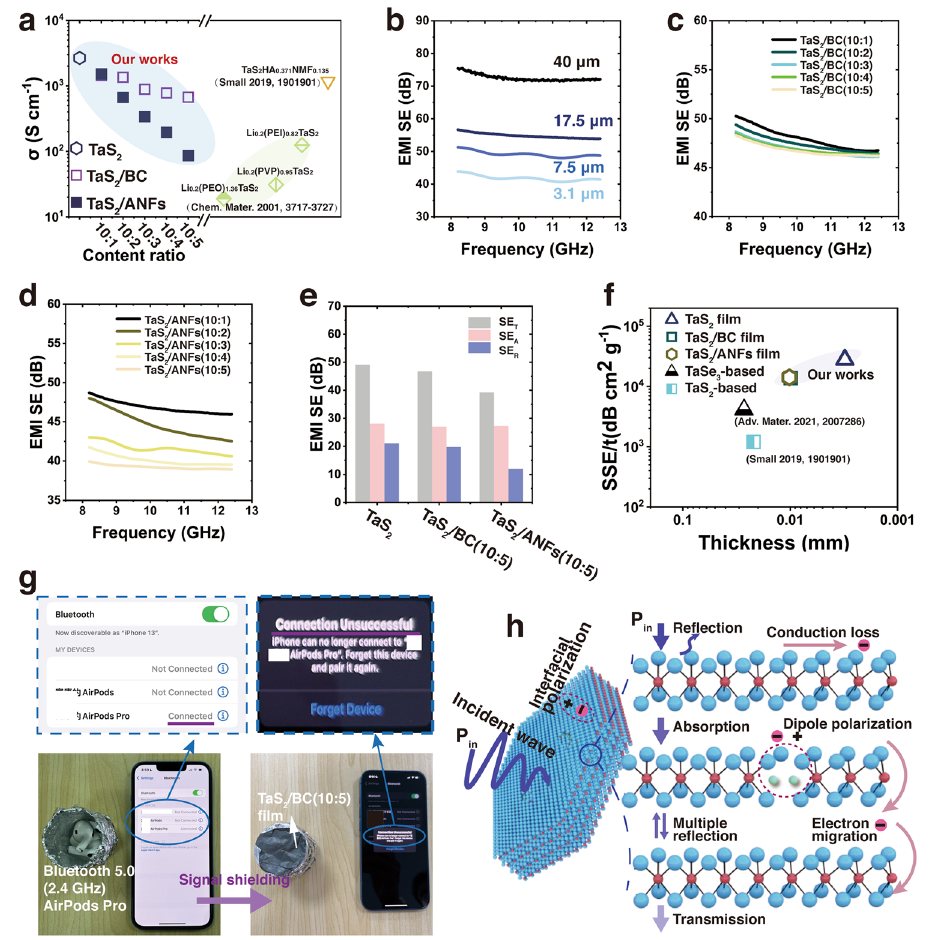
Fig. 6 Electrical conductivity and EMI SE of TaS 2 films. a Electrical conductivity of TaS 2 freestanding film, TaS 2 /BC, and TaS 2 /ANFs compos- ite films. b EMI SE of TaS 2 freestanding films at different thicknesses. EMI SE of c TaS 2 /BC and d TaS 2 /ANFs composite films. e Average EMI SE T , SE A , and SE R in 7.5-μm-thick TaS 2 freestanding film, TaS 2 /BC (10:5), and TaS 2 /ANFs (10:5) composite films. (Note: TaS 2 content is the same for each tested sample). f Comparison of EMI SSE/t of TaS 2 films with the reported TMDs-based EMI shielding materials. g Demonstra- tion of EMI shielding performance of TaS 2 /BC (10:5) composite film. h Schematic illustration of the proposed EMI shielding mechanism of the